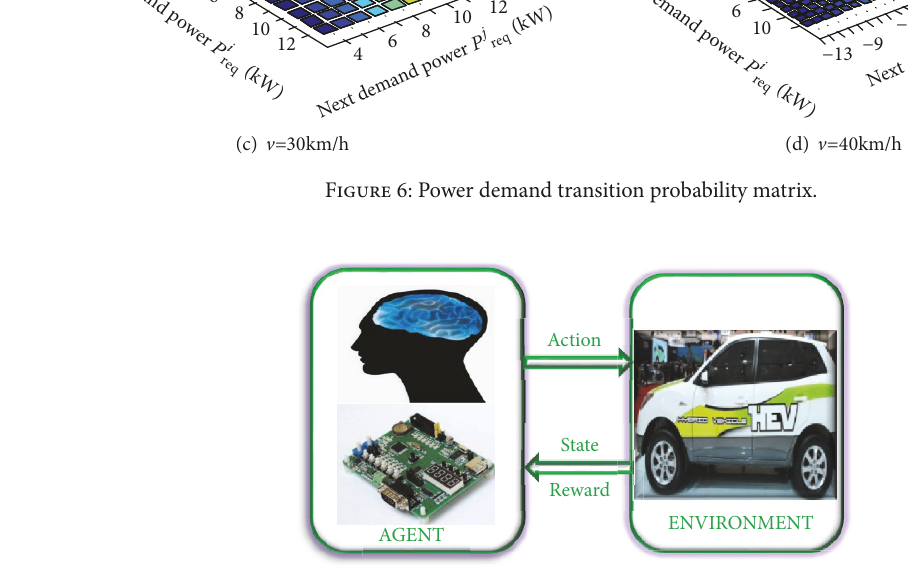
Figure 7: Schematic of reinforcement learning.